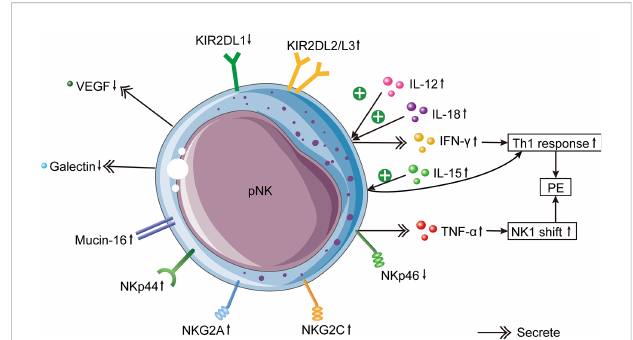
FIGURE 2 Changes of pNK cells in PE. In PE patients, increased circulating pro- in fl ammatory cytokines IL-12 and IL-18 induce IFN- g production by pNK cells, which leads to the Th1 immune bias of PE. In addition, elevated circulating IL-15 induces the systemic in fl ammatory response by activating pNK cells. pNK cells from PE cases produce less VEGF and more galectin. Mucin-16 has a stronger binding with pNK cells in PE. The inhibitory NKG2A, activating NKG2C and NKp44 in pNK cells of PE patients are increased. Besides, KIR2DL1 + NK cells are decreased, whereas KIR2DL2/3 + NK cells are increased in PE. In females with PE, there is a lower expression of NKp46 on pNK cells, which causes the increased expression of TNF- a produced by pNK cells. Higher production of TNF- a results in an NK1 shift of NK cells, which is one of the etiologies of